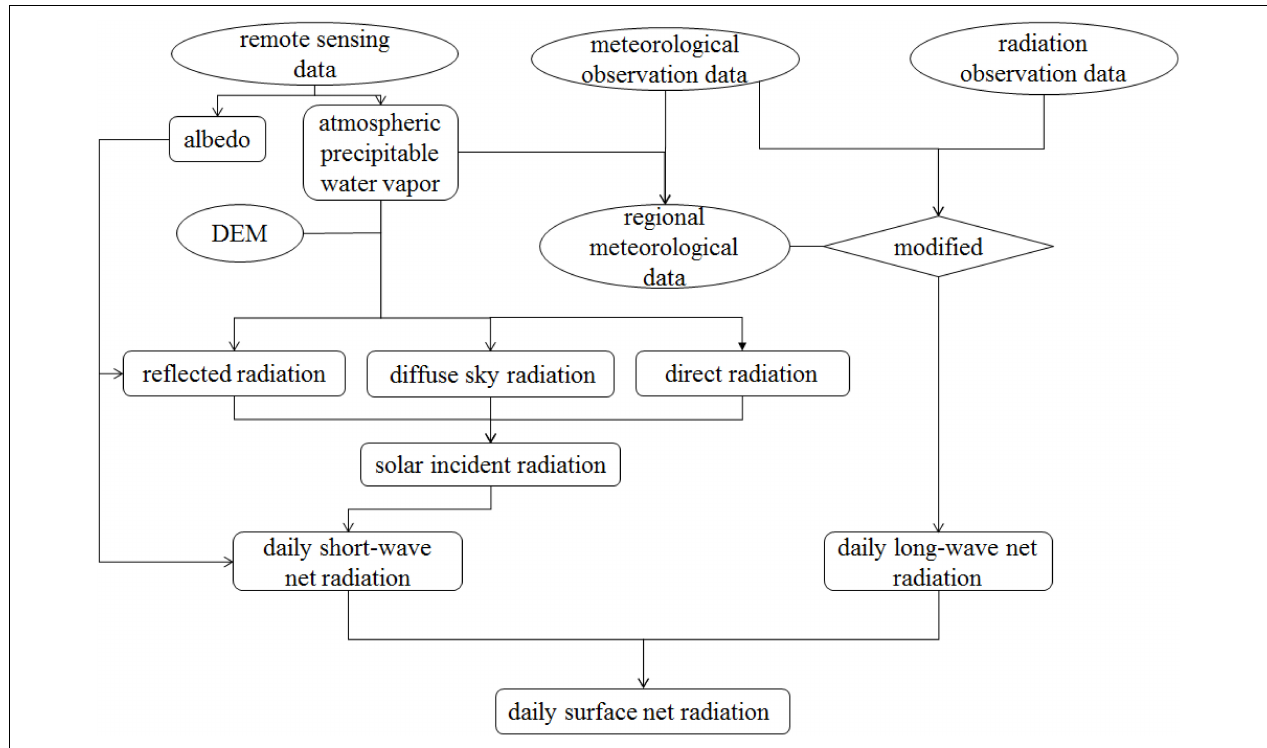
FIGURE 1 | Flow diagram of the estimation of the surface net radiation under clear-sky conditions in this